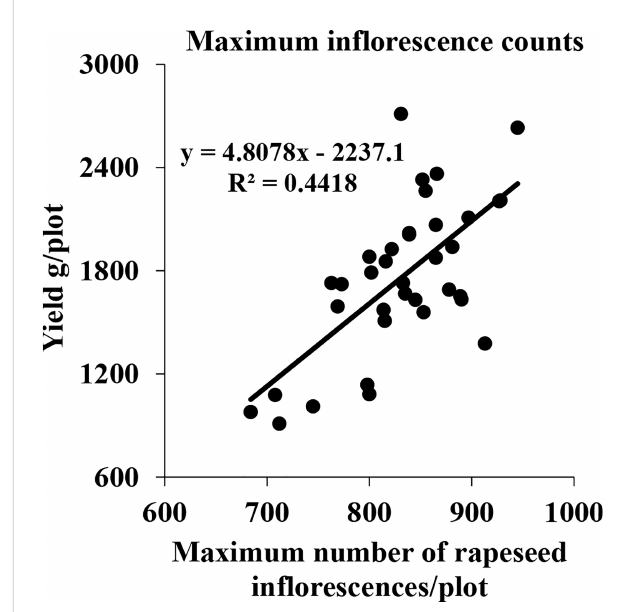
FIGURE 12 Correlation between the seed yield and maximum number of all rapeseed in fl orescences of each plot in fi ve periods in fi eld A in